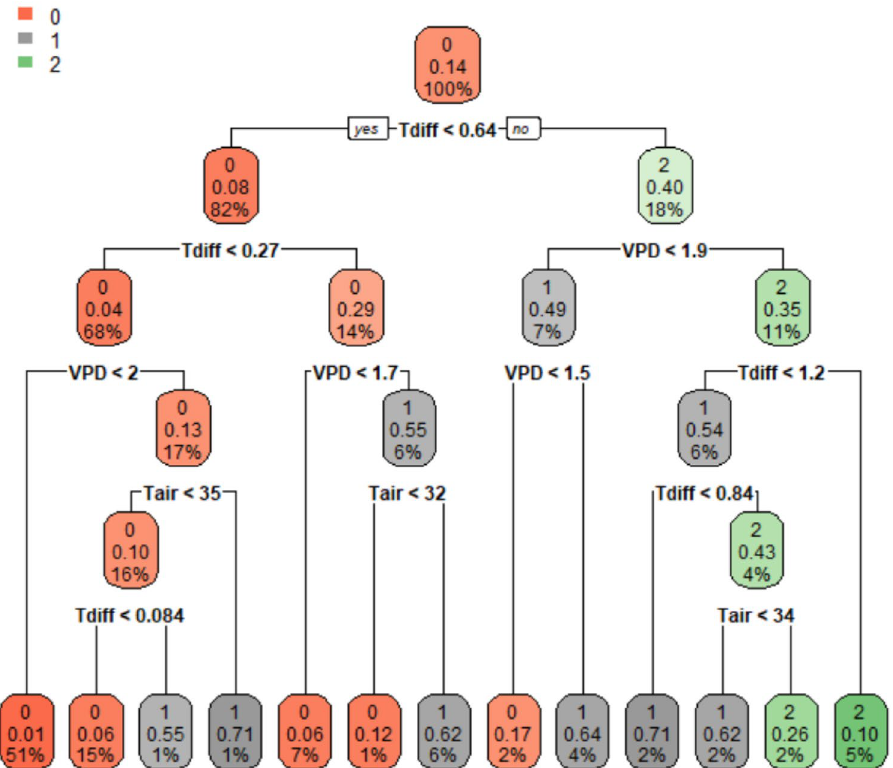
Figure 3. Classification and regression tree model for classifying ordinal drought status. At each intermediate node, a case goes to the left child node only if the condition is satisfied. Each node in the model has three values, the top value is the predicted class at this node, the second value is the probability that the Y = 1 (medium stress), and the third value is the number of observations for this node as a percentage of the whole dataset. The predicted class 0, 1, and 2 represent low, medium, and high stress, respectively.